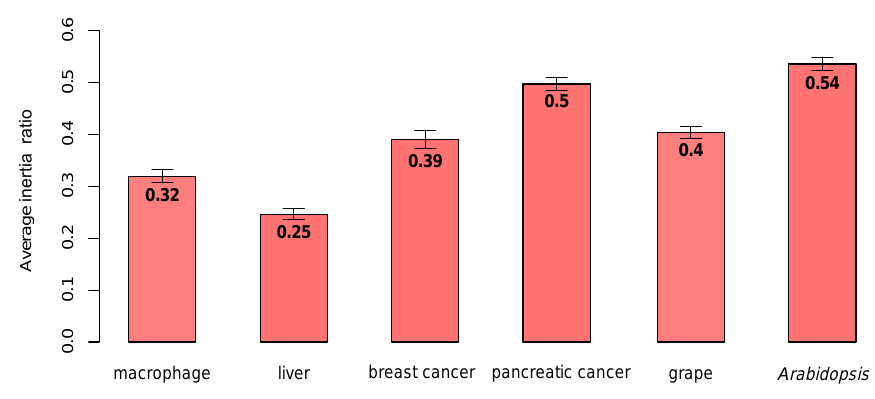
Figure 4. The average proportion of variance captured by eigengenes obtained by the k-eigengene al- gorithm. The proportion of variance in the pancreatic cancer and Arabidopsis datasets was the